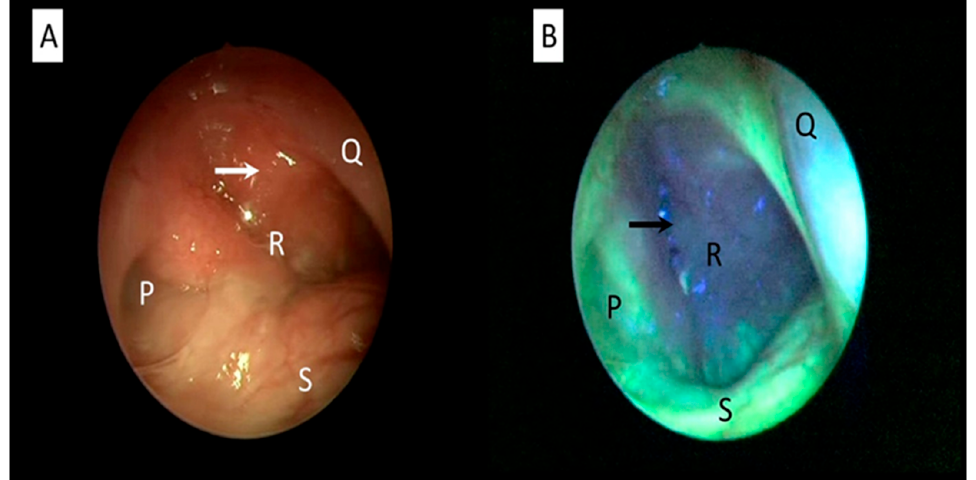
Figure 3. Nasopharyngeal examination of a patient with nasopharyngeal cancer using white-light ( A ) and autofluorescence mode ( B ). Abnormal mucosa around the cancerous area is clearly seen as autofluorescent loss compared with the normal healthy mucosa, which appears as cyan-green. An arrow indicates cancerous mucosa. Structure P: eustachian tube. Q: posterior part of nasal septum, R: nasopharynx, S: floor of nasal cavity (Figure is from author’s own collection).